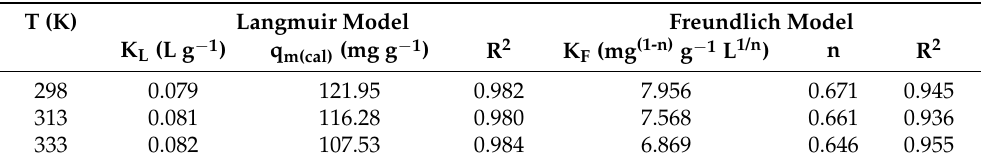
Table 4. Parameters of the Langmuir and Freundlich models for the adsorption isotherms of Hg(II) onto rGO considering three different temperatures.